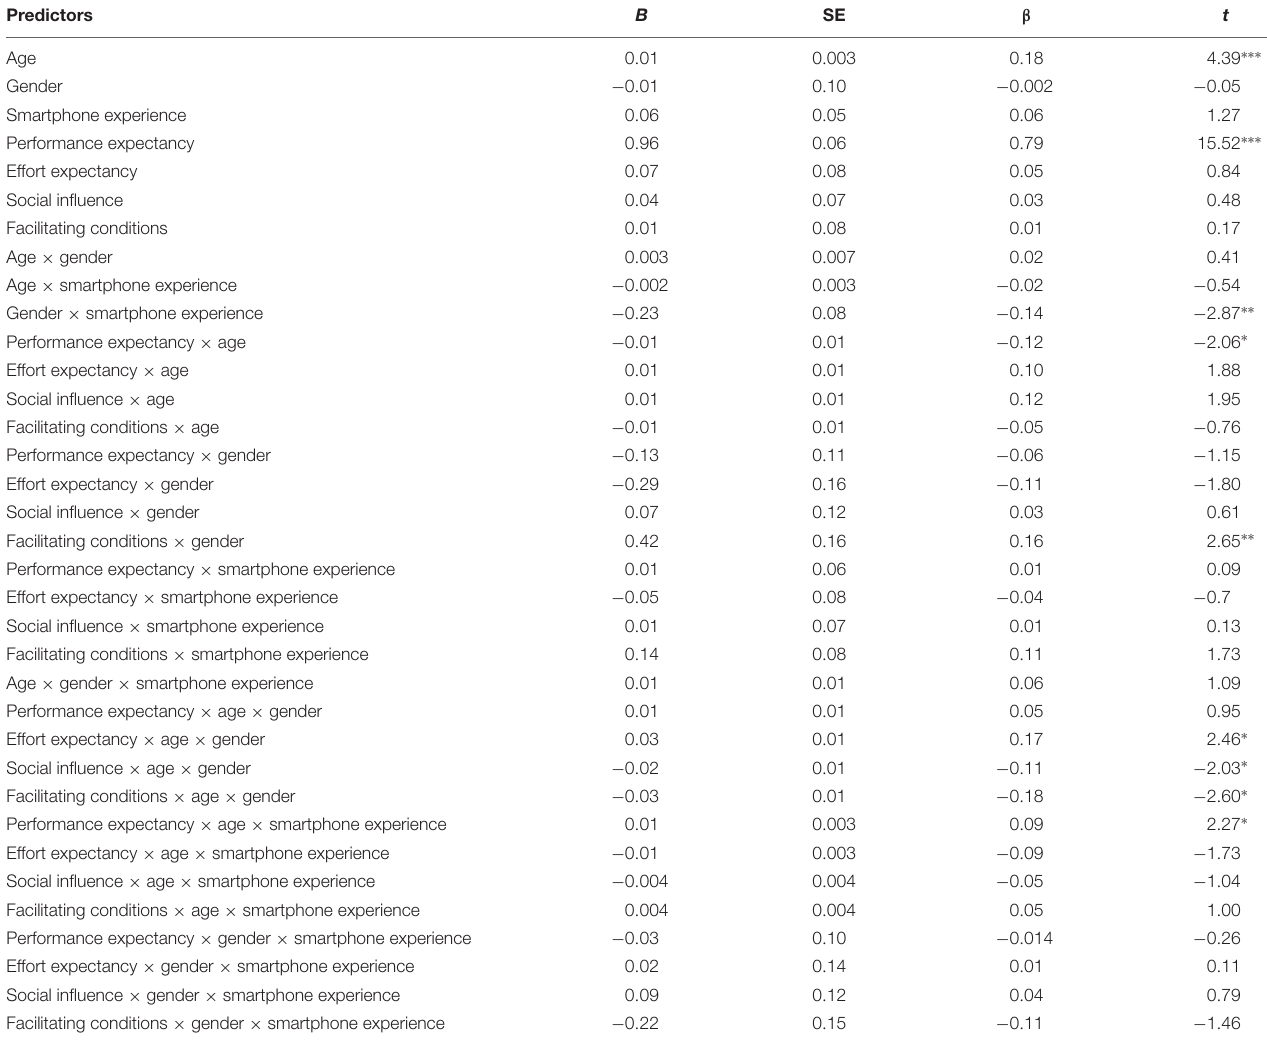
TABLE 2 | Final model with all main effects and interactions of age, gender, smartphone experience, and ICT acceptance determinants on participants’ behavioral intention to use mHealth.